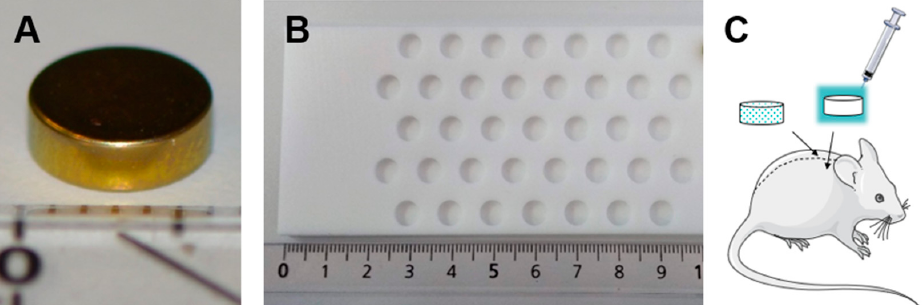
Figure 1. Implant design and implantation. ( A ) Titanium implant used in the study. ( B ) By using a custom-made Teflon mold, PMMA discs of the same shape and size as the titanium discs were obtained for the third phase. ( C ) Illustration of the two implants placed bilateral of the spine during the first and second phase. The implant on the left (dotted) represents the pre-inoculated implant. The box around the sterile implant demonstrates the inoculum pipetted (syringe) after implantation. In the third phase PMMA discs or titanium implants were inserted unilaterally, and the inoculum was pipetted.